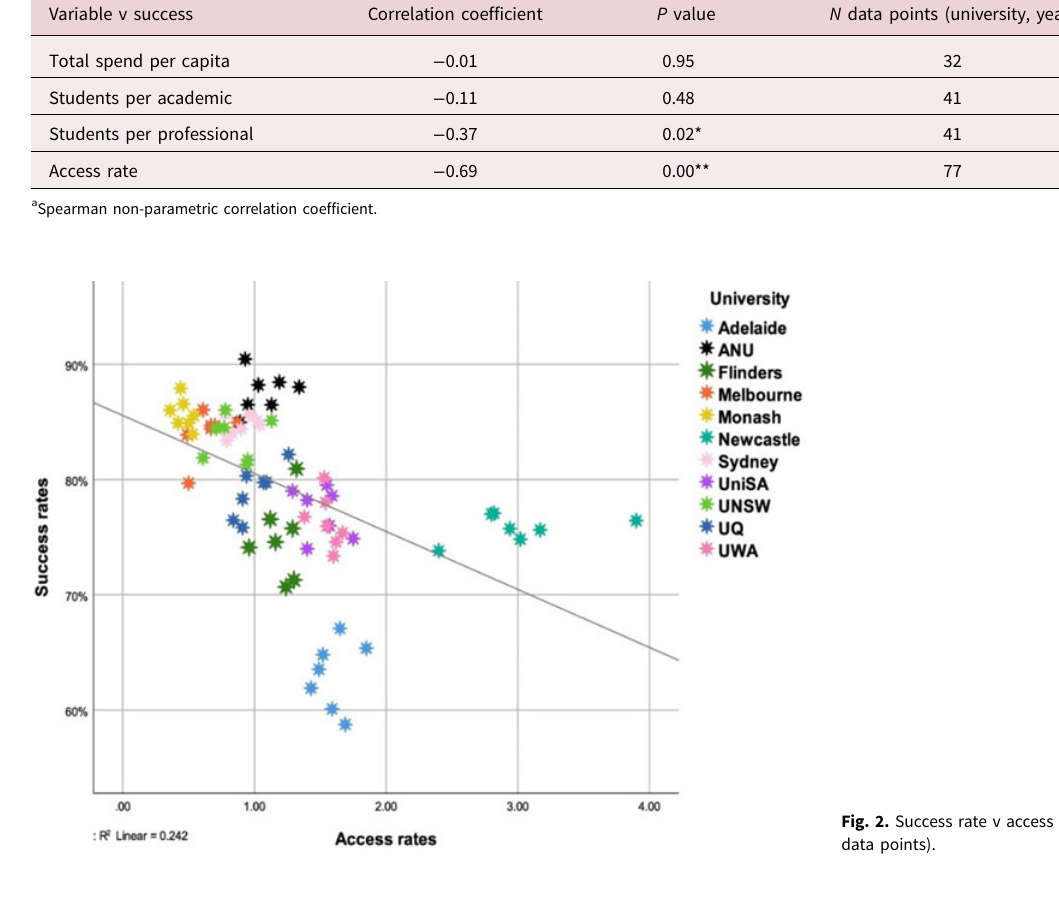
Table 4. Correlation a between spending, staffing and access with success Variable v success